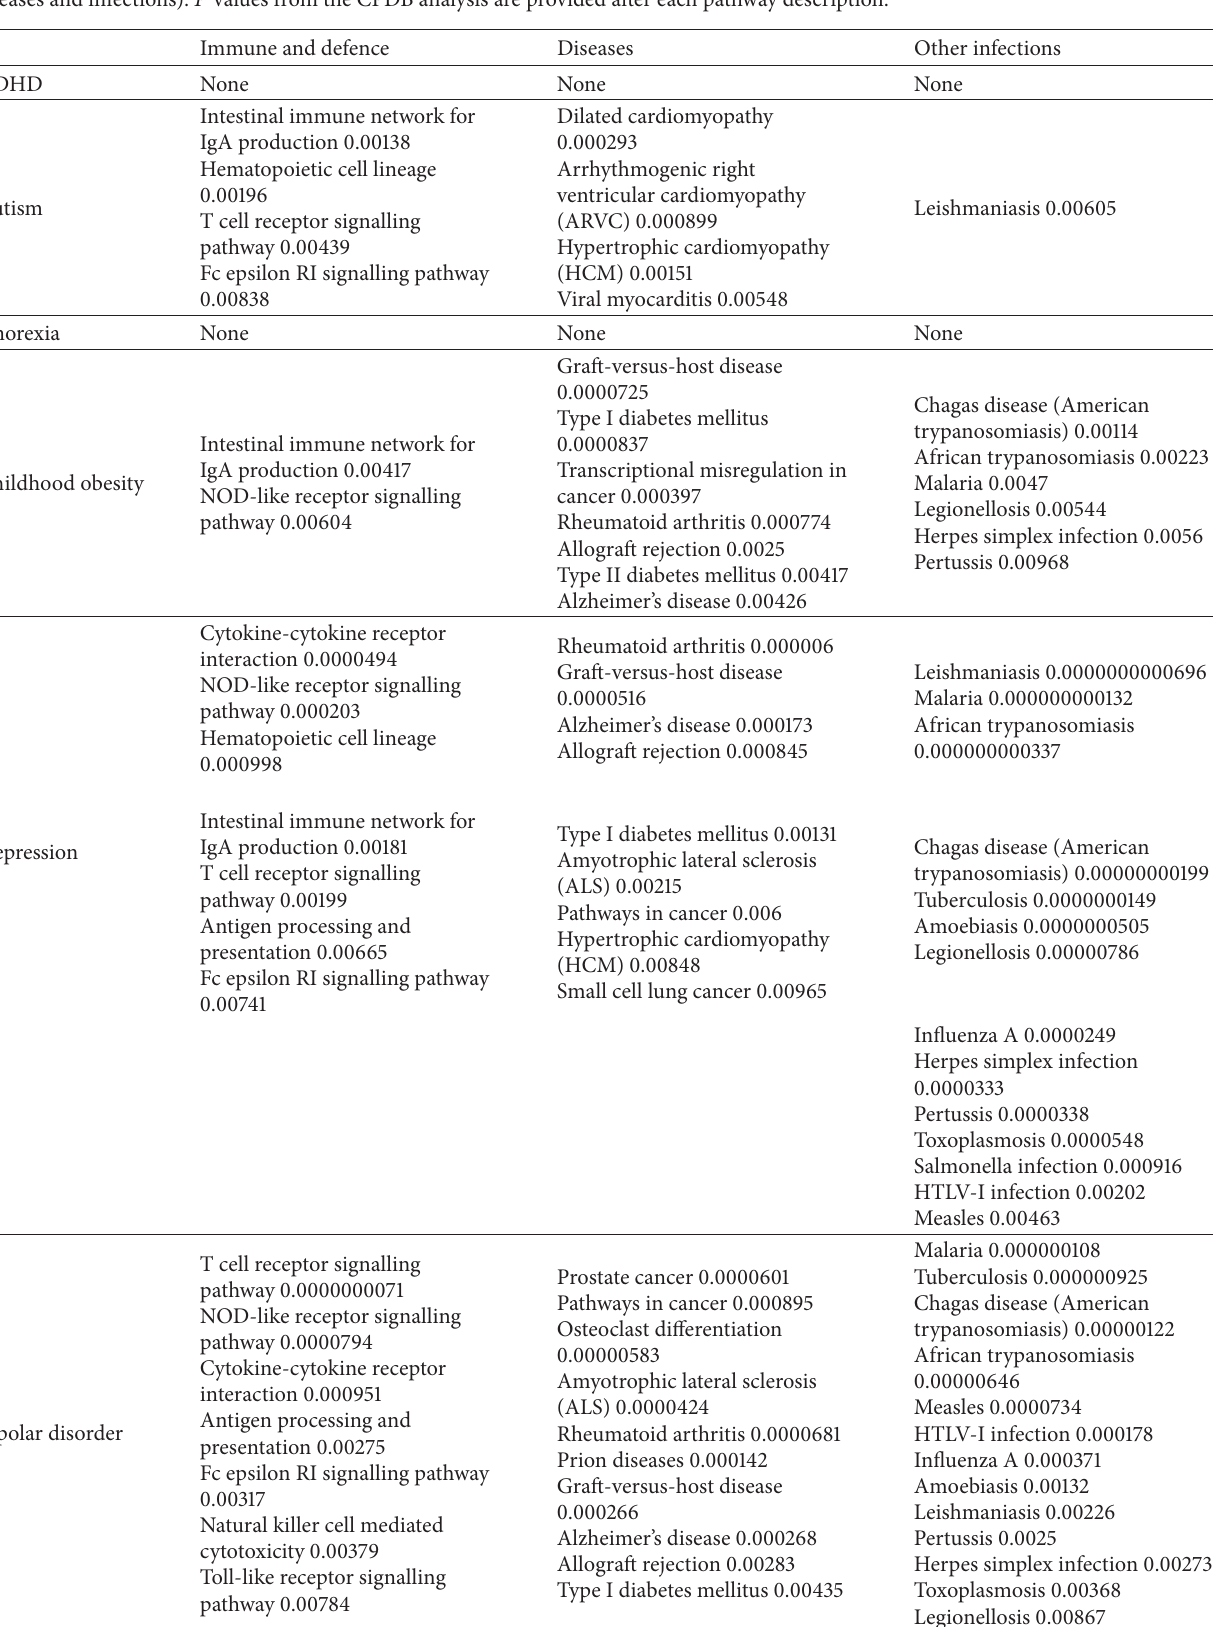
Table 5: Significantly enriched KEGG pathways within the overlapping interactome/susceptibility gene datasets (Immune related, other diseases and infections). 𝑃 values from the CPDB analysis are provided after each pathway